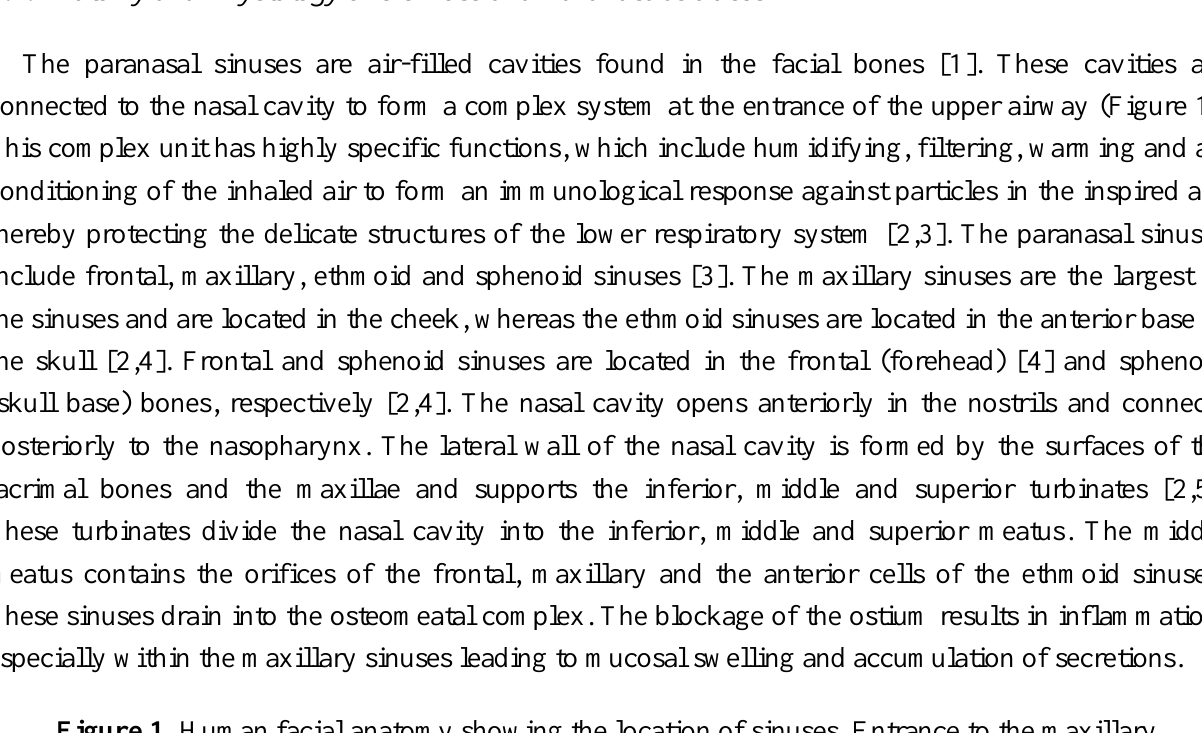
Figure 1. Human facial anatomy showing the location of sinuses. Entrance to the maxillary sinuses can be blocked by polyps and chronic inflammation, making it impossible for nasal sprays to penetrate the maxillary